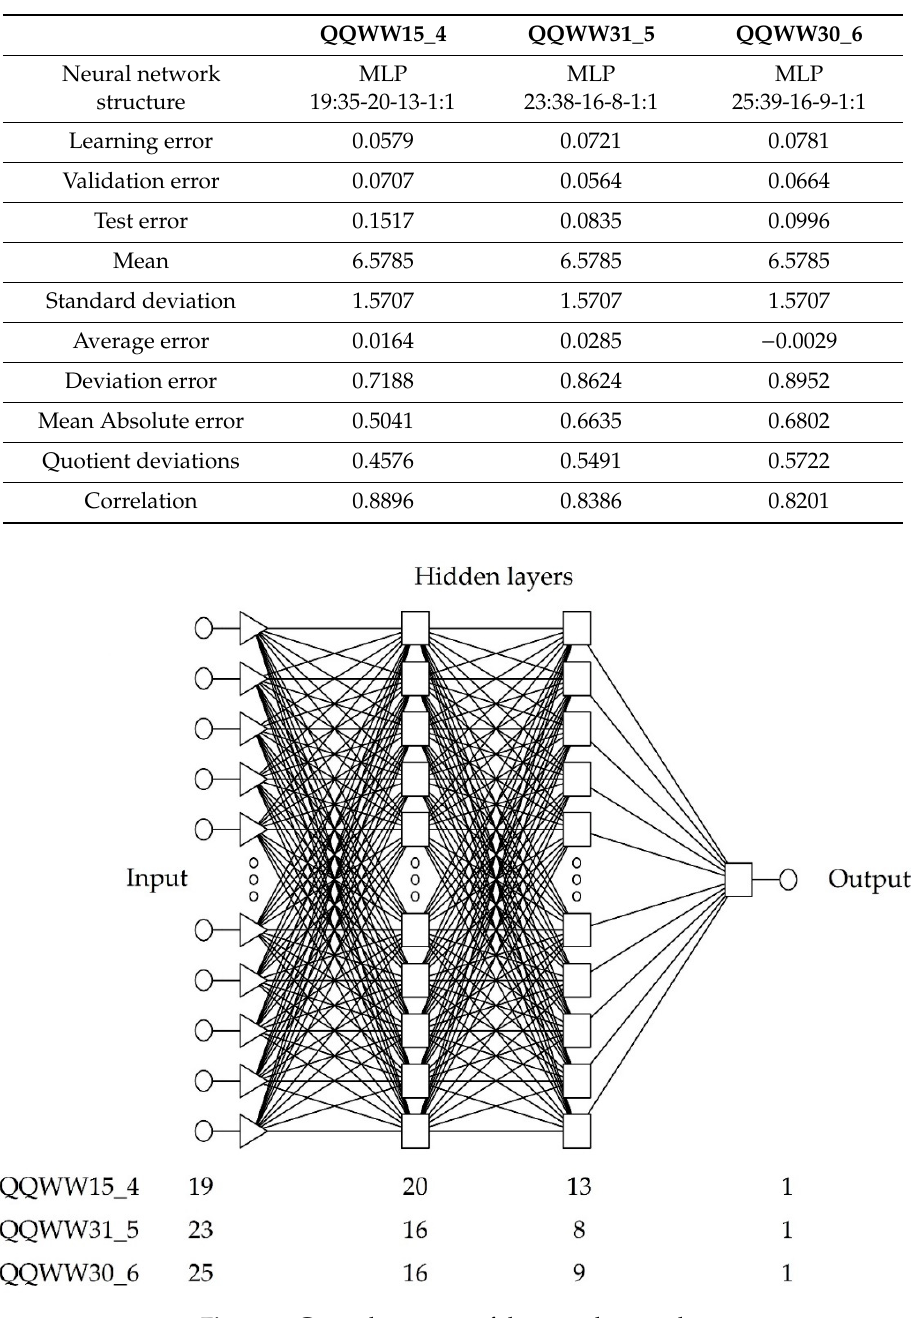
Figure 2. General structure of the neural networks. Table 4. Measures prediction ex post of analyzed neural